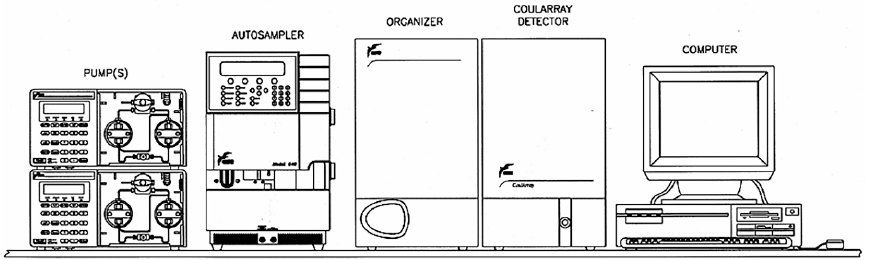
Figure 2. LC system with CoulArray detector (Thermo Scientific™ Dionex™ CoulArray™ coulometric array detector).